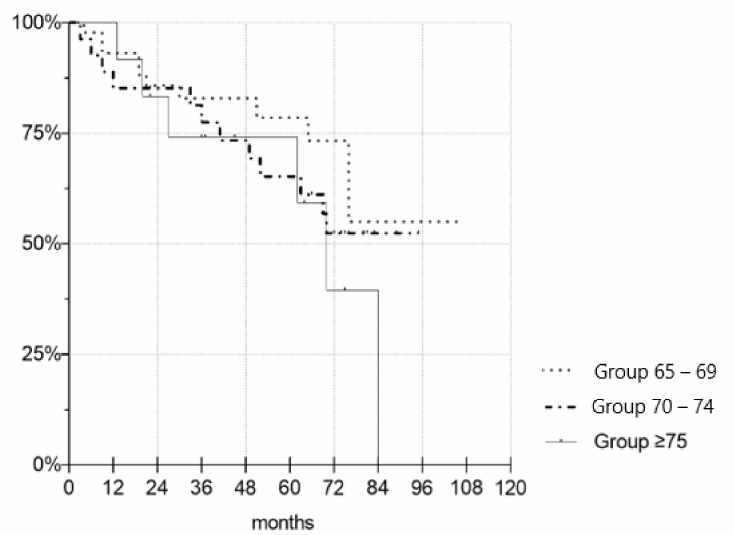
Figure 3. Kaplan–Meier survival plot demonstrating death-censored patient survival. There were no significant differences in the patient survival time between the groups ( p = 0.149 for Gr. 7074, p = 0.438 for Gr.